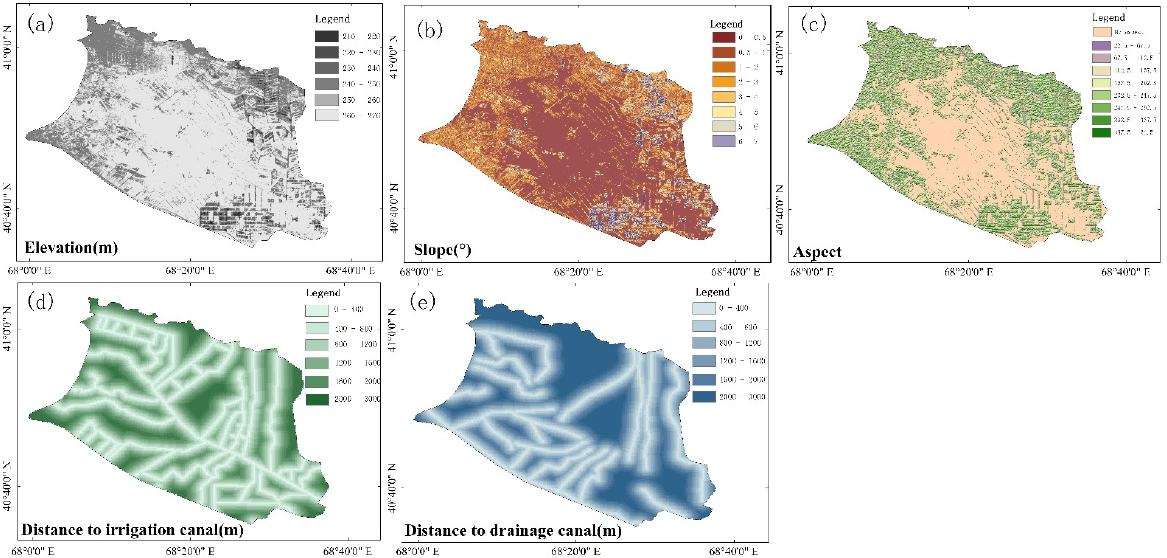
Figure 8. Spatial distribution of factors influencing soil salinity in the Mahtaaral district: ( a ) eleva ‐ tion; ( b ) slope; ( c ) aspect; ( d ) distance to drainage canal; and ( e ) distance to irrigation canal.